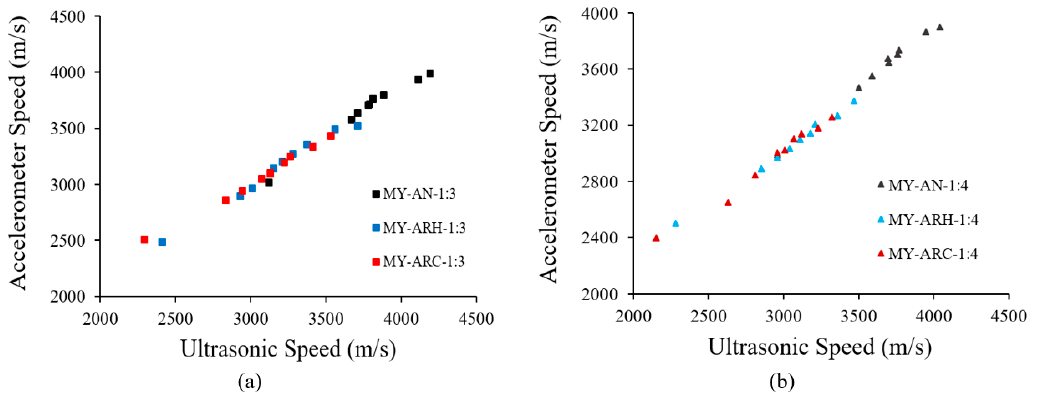
Figure 8. Correlation between the speeds measured with ultrasound and the rates measured with the Arduino equipment. ( a ) Mortars with a cement / aggregate ratio of 1:3; ( b ) mortars with a cement / aggregate ratio of 1:4. Table 6. Linear regression adjustments and R 2 coefficients for the relationship of speed measurements obtained by ultrasound and by the Arduino system.